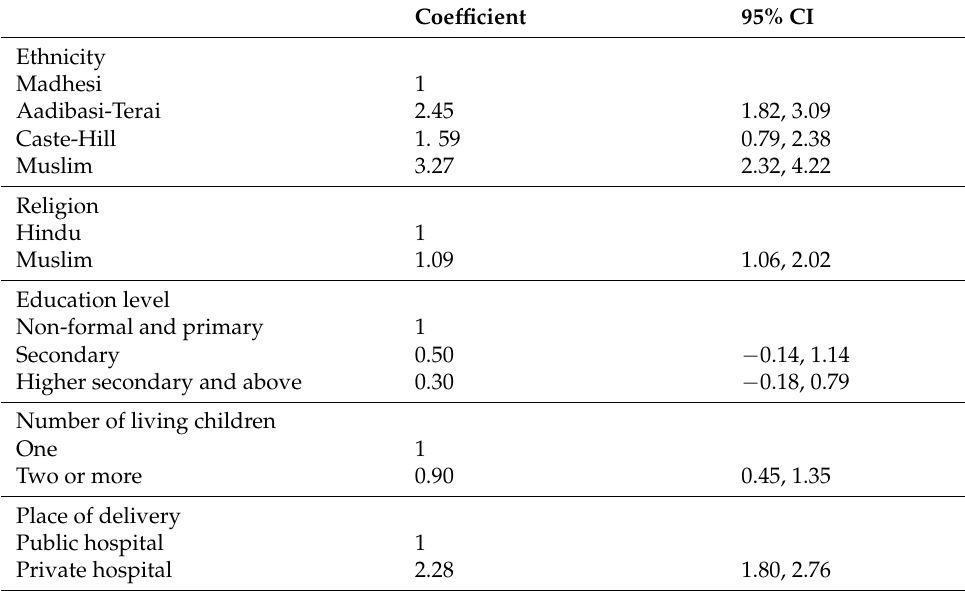
Table 5. Multiple linear regression analysis for the factors ( N =